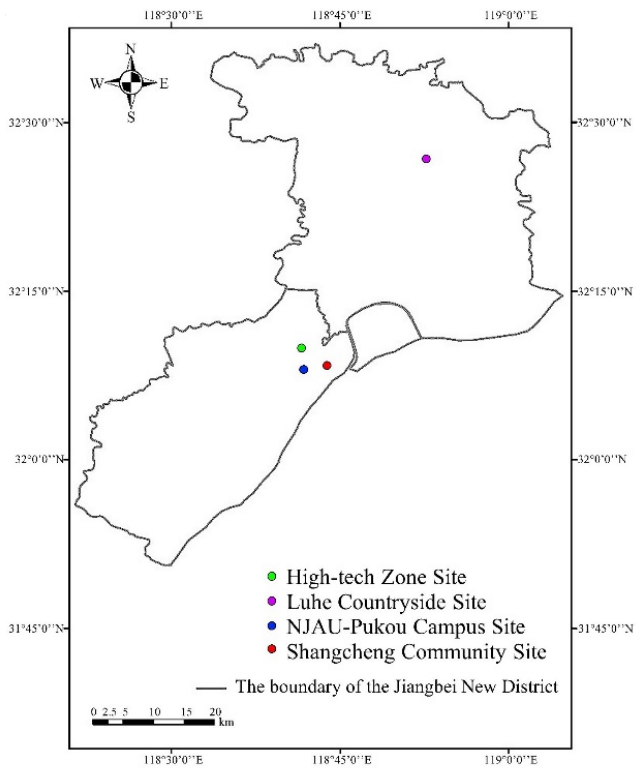
Figure 1. Spatial distribution of four ambient air quality monitoring sites in Jiangbei New District.